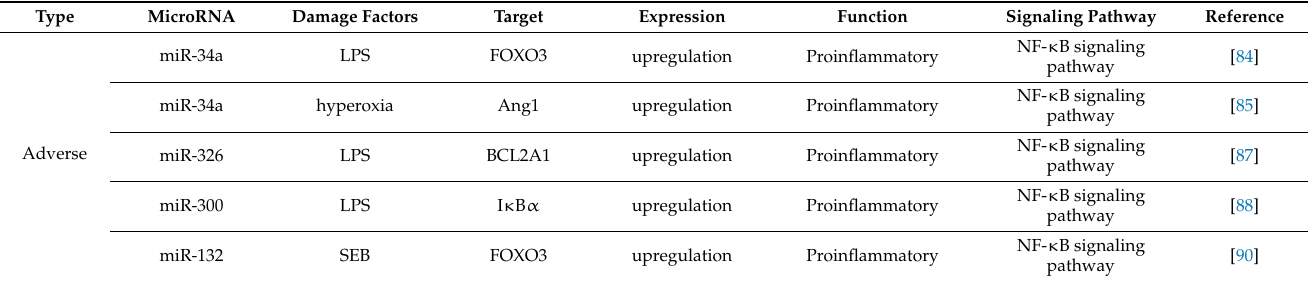
Table 1. Targets and function of microRNA in